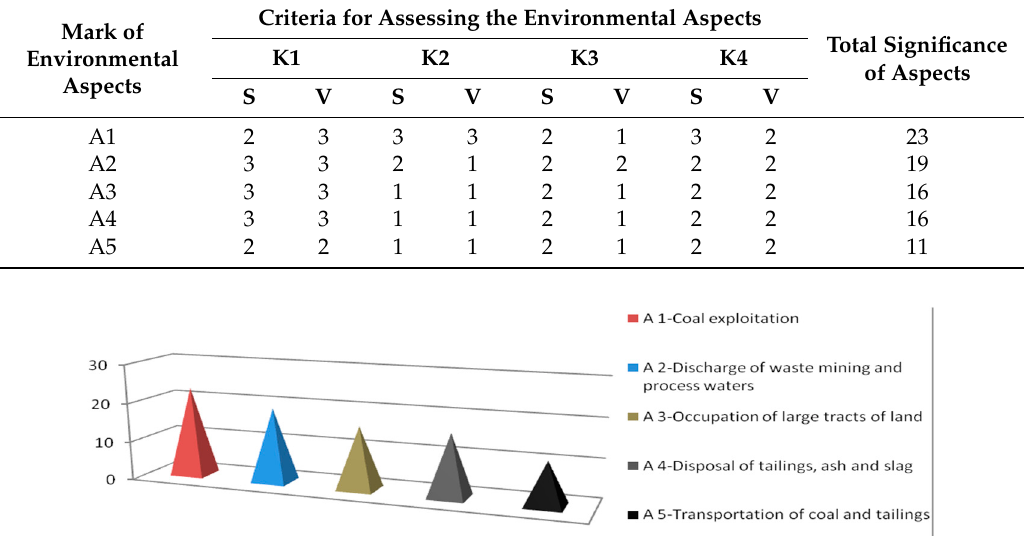
Figure 2. Significance of ranked environmental aspects.